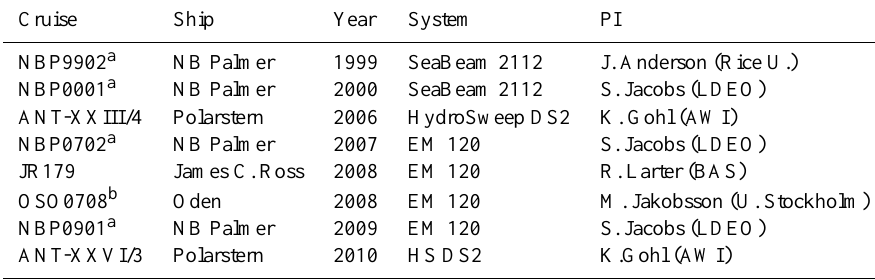
Table 1. Expeditions with multibeam data used for this